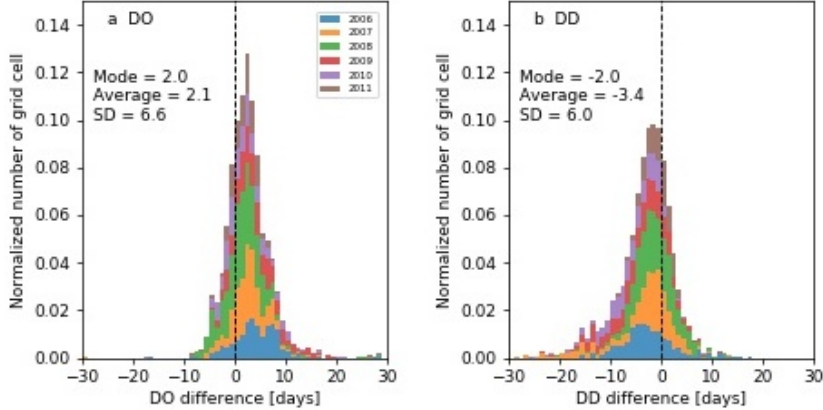
Figure 7. DO and DD differences between AMSR-E and MERIS. SD: standard